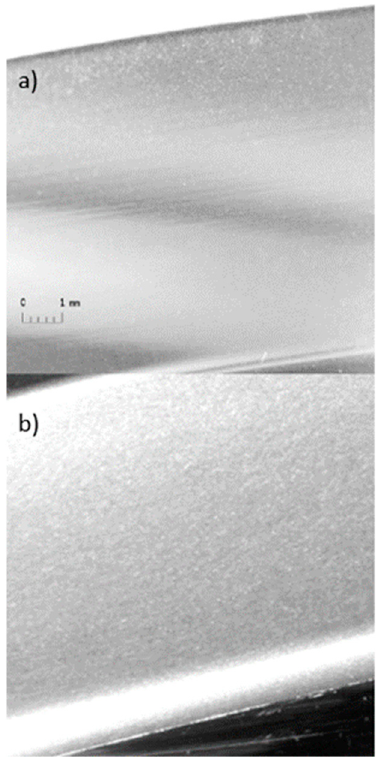
Figure 16. Unaided eye inspection for workpiece before ( a ) and after ( b ) Stream Finishing process optimization.